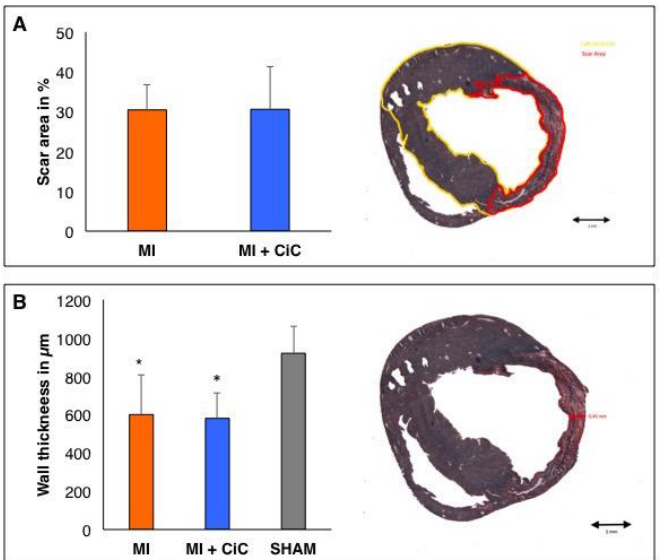
Figure 8. Heart sections of four horizontal infarction levels (5 µm) stained with Sirius Red (collagen) and Fast Green (non-infarcted myocardium). Right side: Representative sections of the MI group showing measurements of ( A ) scar size and ( B ) wall thickness of the infarcted region. * p < 0.05 compared to SHAM group.